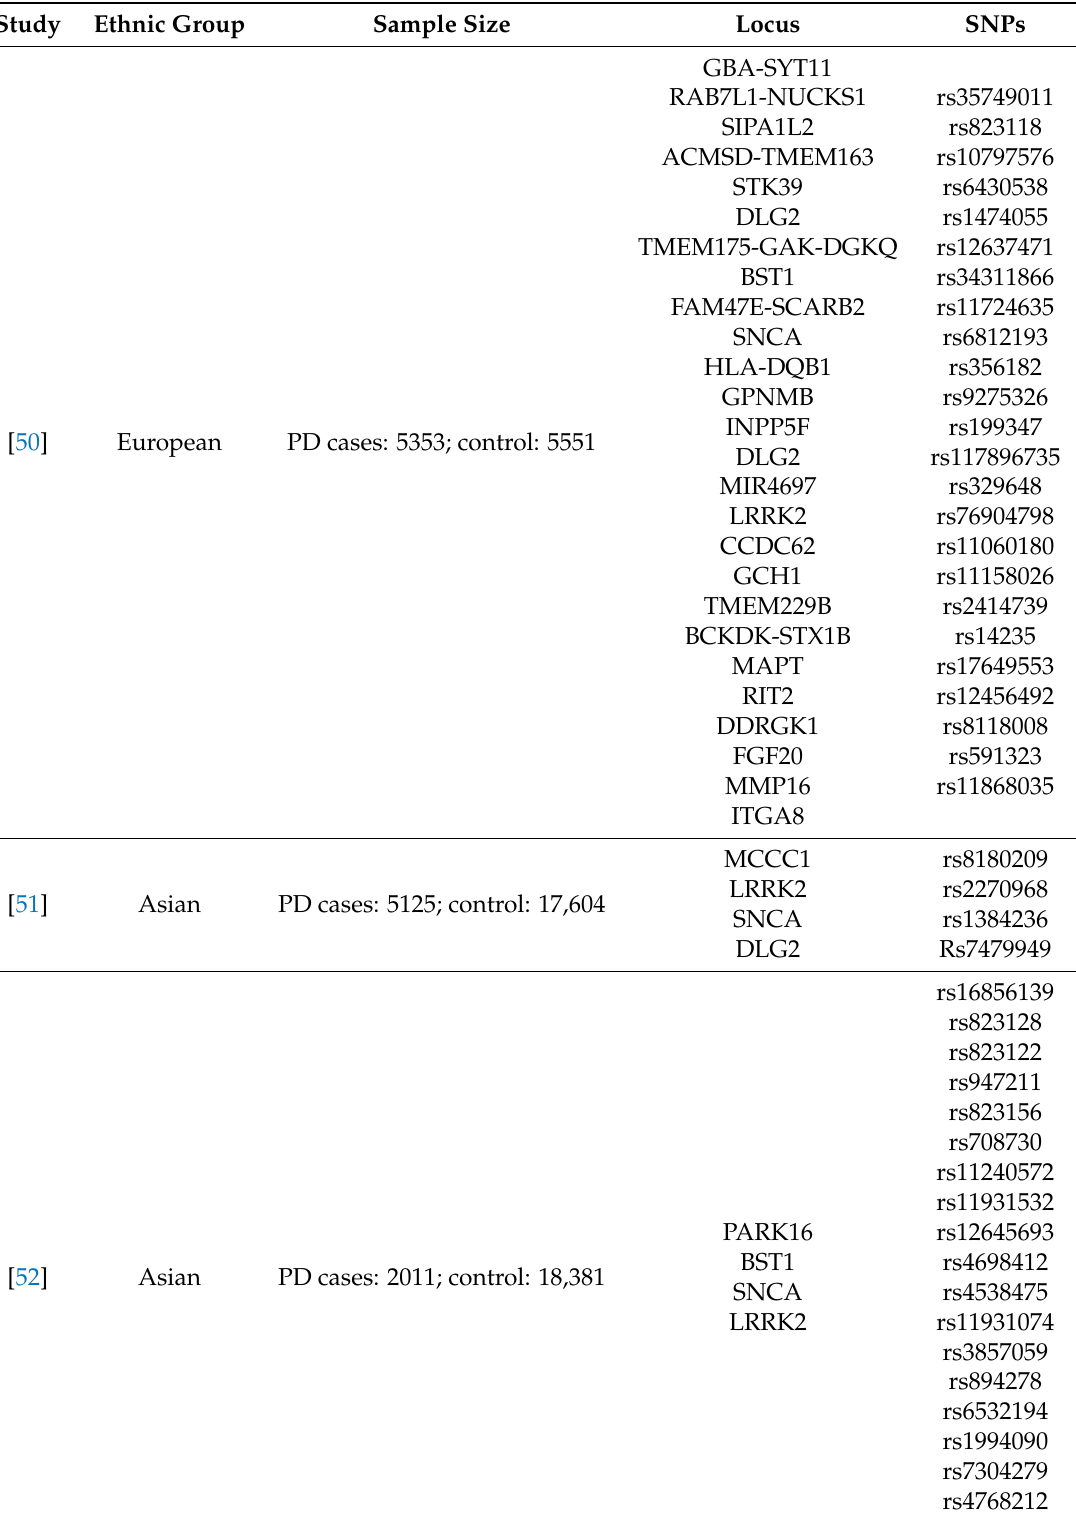
Table 3. Genome-wide association studies (GWAS) in